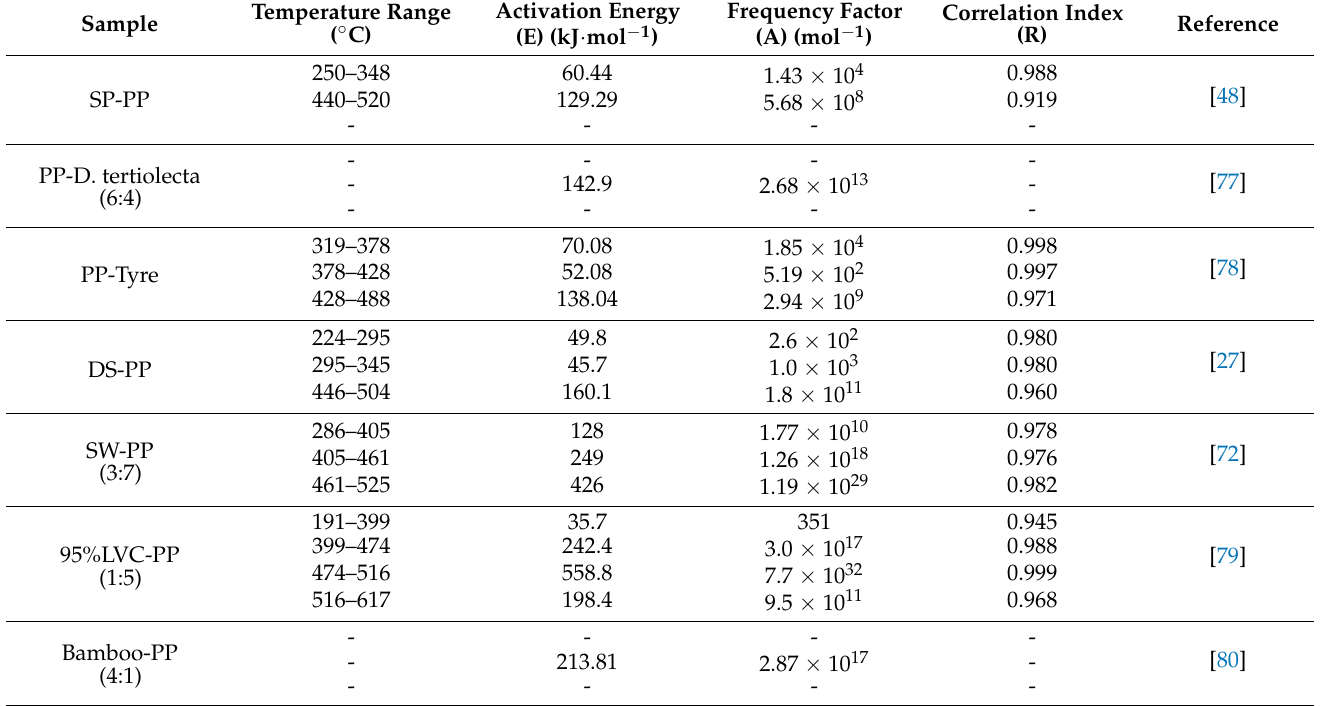
Table 3. Pyrolysis kinetic parameters of other samples co-pyrolysis with